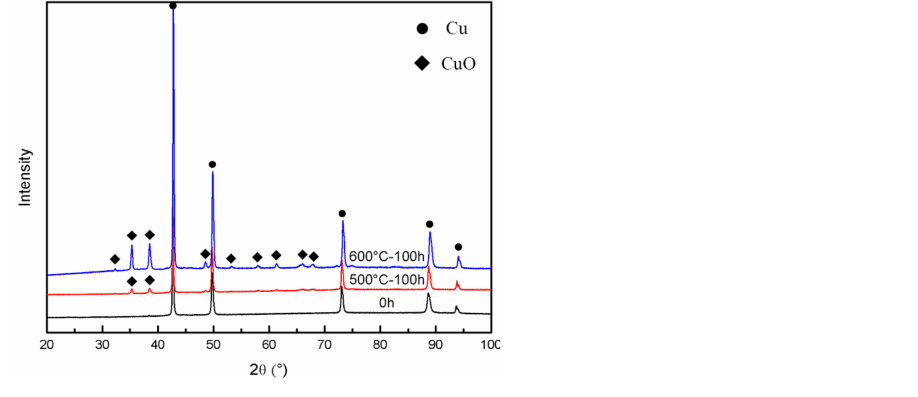
Figure 6. XRD patterns of the as-sprayed coatings after heat treatment at 500 ◦ C and 600 ◦ C for 100 h, respectively.